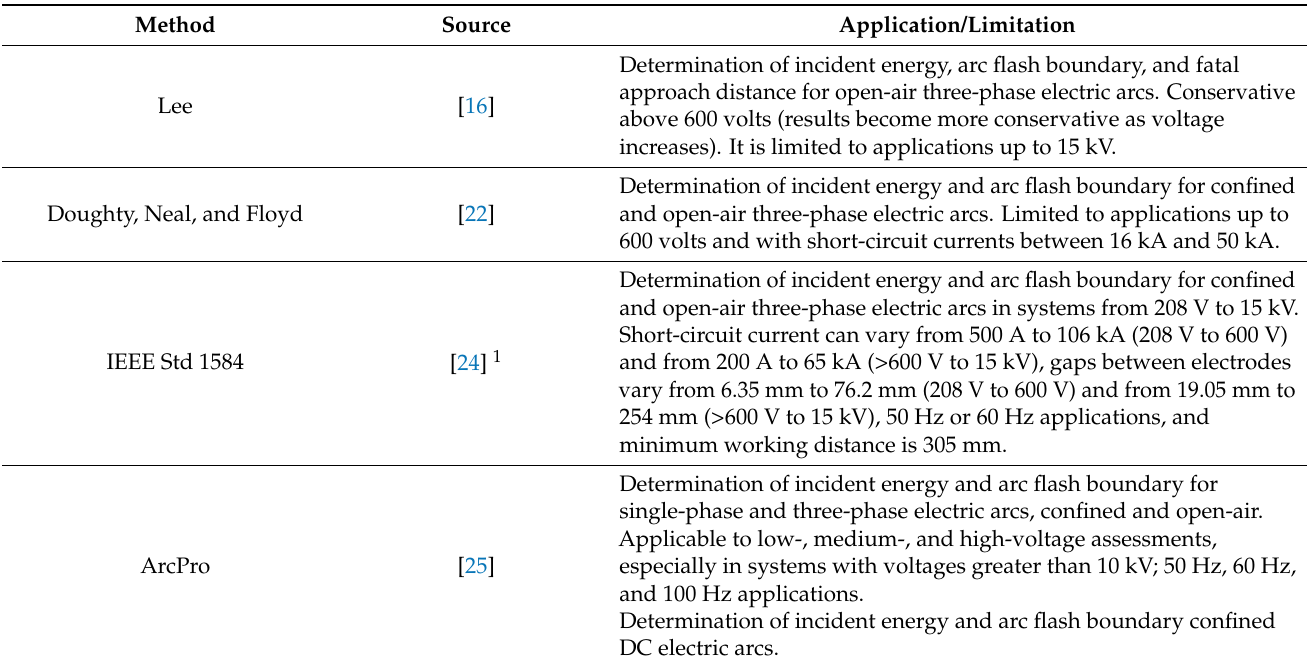
Table 1. Incident energy estimation methods